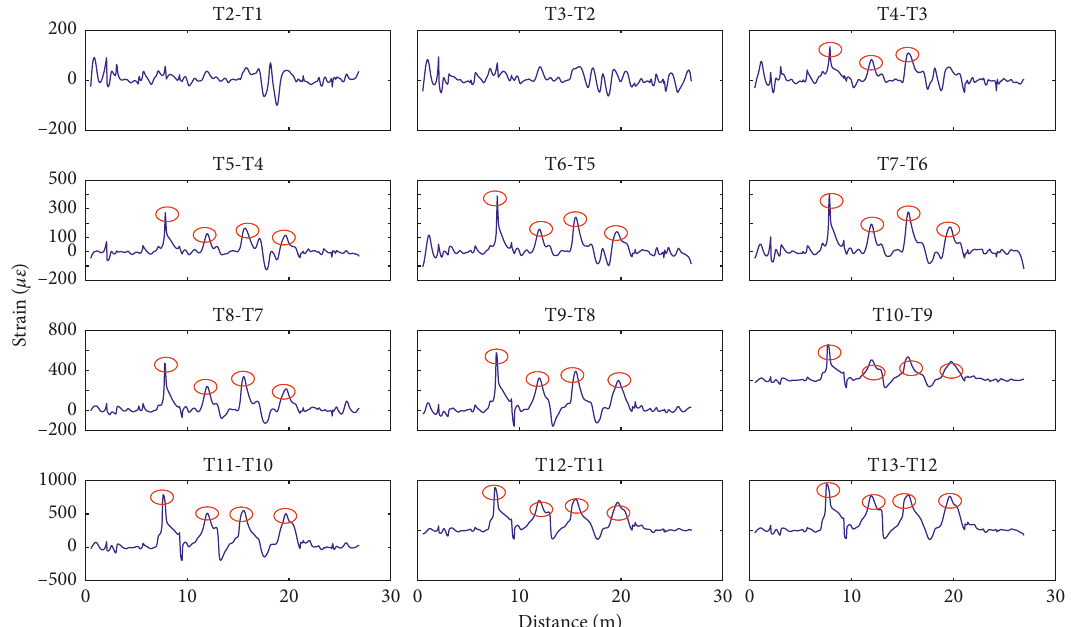
Figure 10: Differential time series data: BOFDA